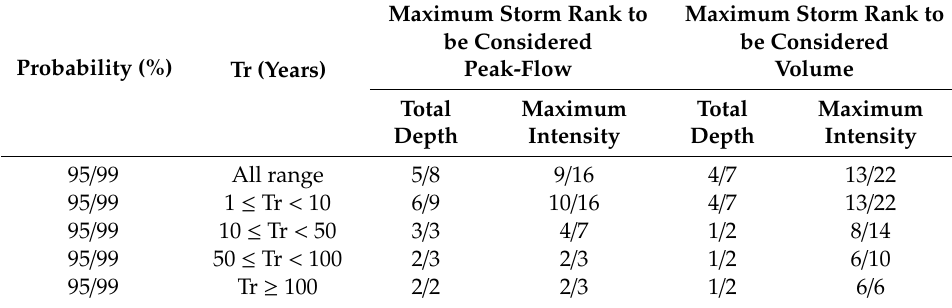
Table 2. Maximum storm rank required to obtain 95% and 99% probability of achieving the maximum peak-flow or volume for a specific year, depending on the ranking criteria used and the range of return periods